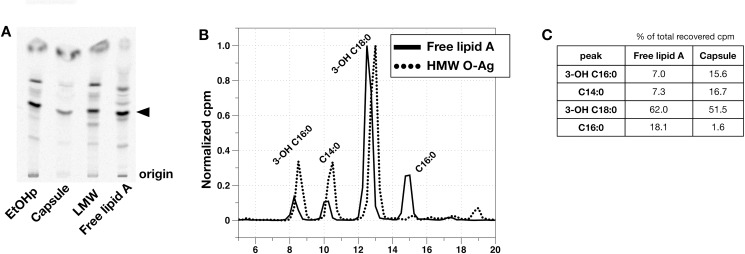
Fatty acid analysis of lipid released from HMW O-Ag capsule by mild acid treatment.A) HPTLC of lipids recovered after mild acid hydrolysis of the indicated preparations. The solvent system used was CHCl3:Pyridine:88% Formic Acid:MeOH:H2O (54:46:16:0:5 v/v). The arrowhead indicates the dominant species in free lipid A. Highly enriched free lipid A was derived via Bligh-Dyer extraction of the EtOHp (see Fig 2F). B) HPLC analysis of [14C] fatty acids derived from free lipid A and lipid released by mild acid treatment of HMW O-Ag. C) The four major peaks in B were quantified and expressed as the % of total recovered cpm.